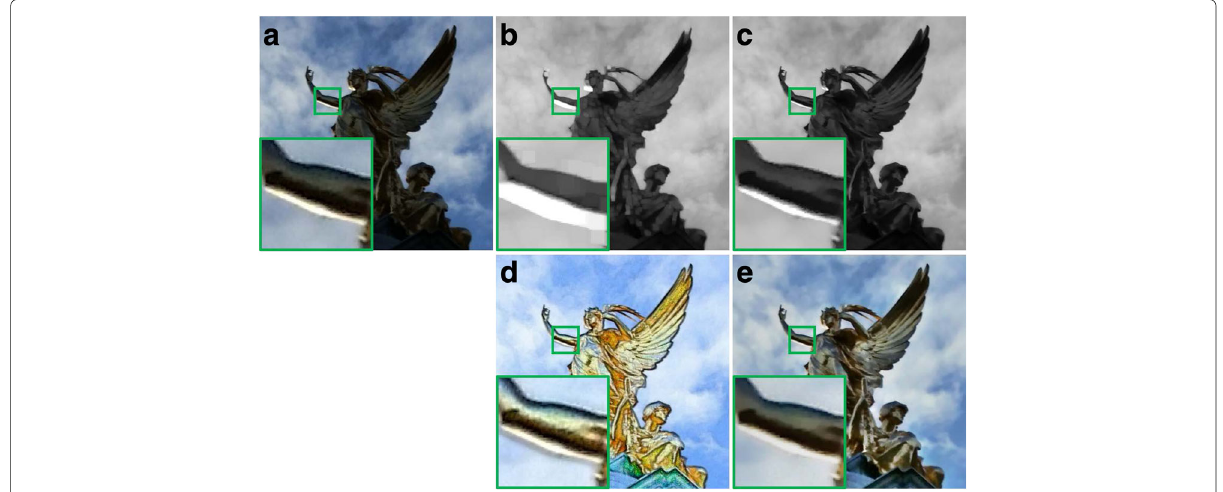
Fig. 1 Comparative results using different bright channels: a input image, b patch-wise bright channel, c proposed bright channel, d resulting image using b and Fu’s method [19], and e resulting image using c and the proposed method